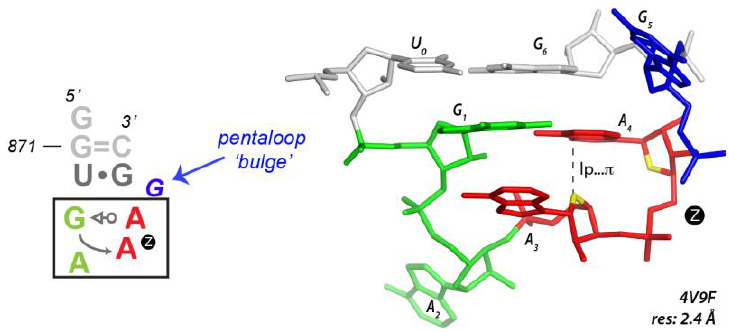
Figure 7. An r(G 1 AAAg) pentaloop that adopts a Z-turn rather than an expected U-turn. The Z-step is marked by a circled “Z” in both the secondary and tertiary structure of the ribosomal H35a tetraloop of the Haloarcula marismortui large ribosomal subunit (PDBid: 4V9F). This motif is conserved in all known ribosome structures. It can be considered as a “shapeshifting” motif exe mplifying the ability of an r(GAAA) loop to switch from U-turns to Z-turns in specific environments [13,31]. Note that a U- turn is characterized by an s3OP2 phosphate…π contact between the first and third residue (not shown), while Z-turns are characterized by sO 4′ 3 between the 3rd and 4th residue and Z anti -turns by sO 4′ 5 between the 3rd and 4th residue (Figure S5).